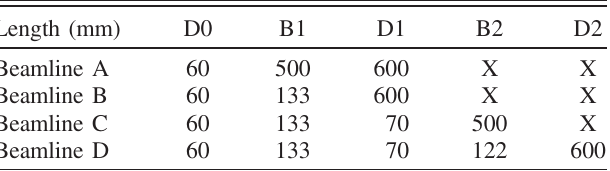
TABLE I. The length of each element in the four beamlines. In the element names, “ D ” denotes a drift, and “ B ” denotes a bending magnet. Each beamline starts with drift D0, followed by B1, D1, B2, then D2. The symbol “ X ” means that the element is